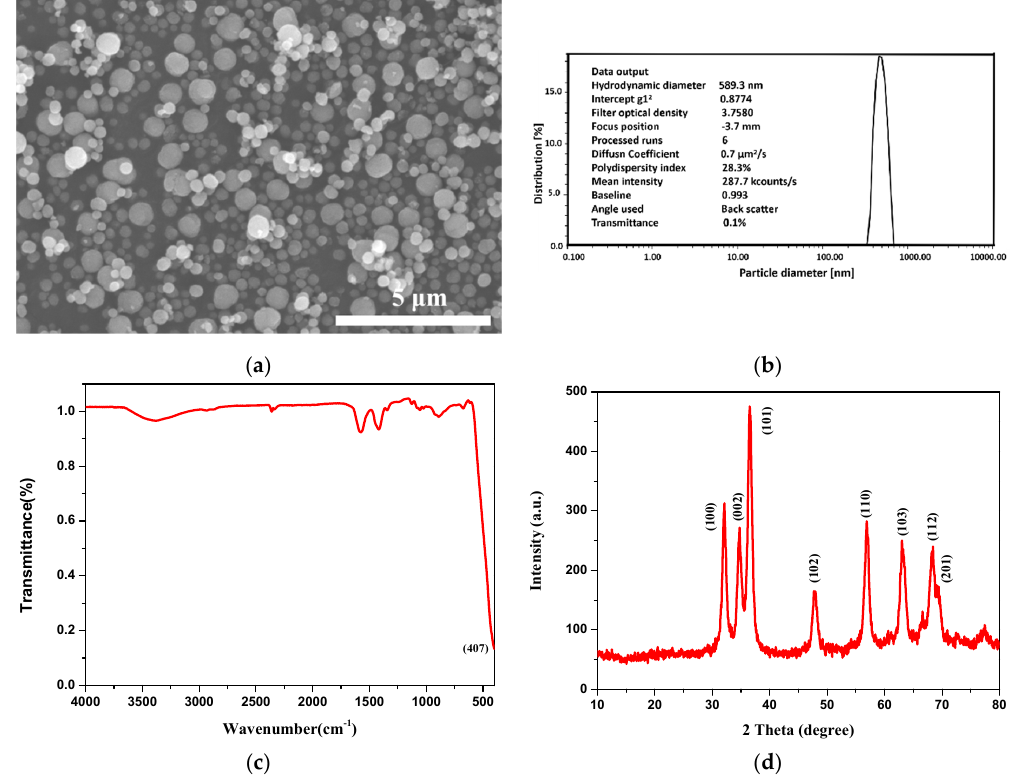
Figure 2. Characterization of ZnO particles ( a ) scanning electron microscopy (SEM) image, ( b ) particle size distribution by intensity, ( c ) Fourier transform infrared spectroscopy (FTIR) spectrum and ( d ) X-ray diffractometry (XRD) spectrum.